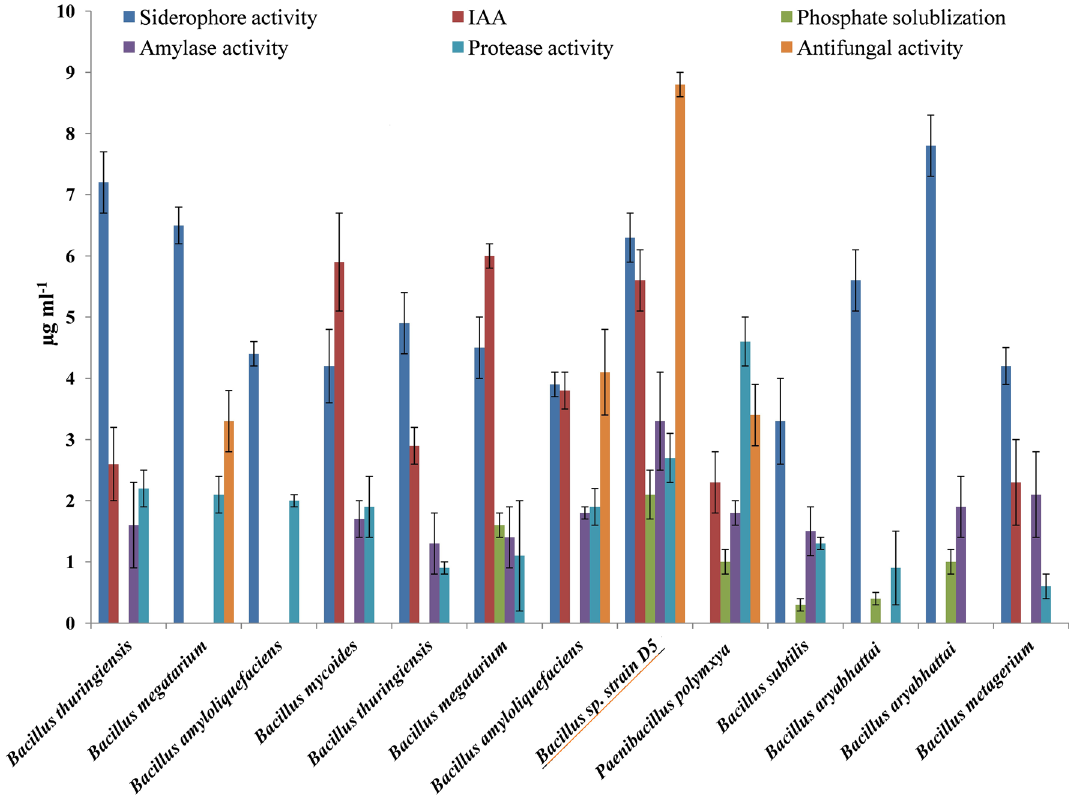
Figure 1. Functional profile of various Bacillus species isolate from cormposphere of saffron for various Plant growth promotion activities and antifungal activity against fungal pathogen Fusarium oxysporum R1 based upon this profile isolate D5 showed maximum potential to be used further in the